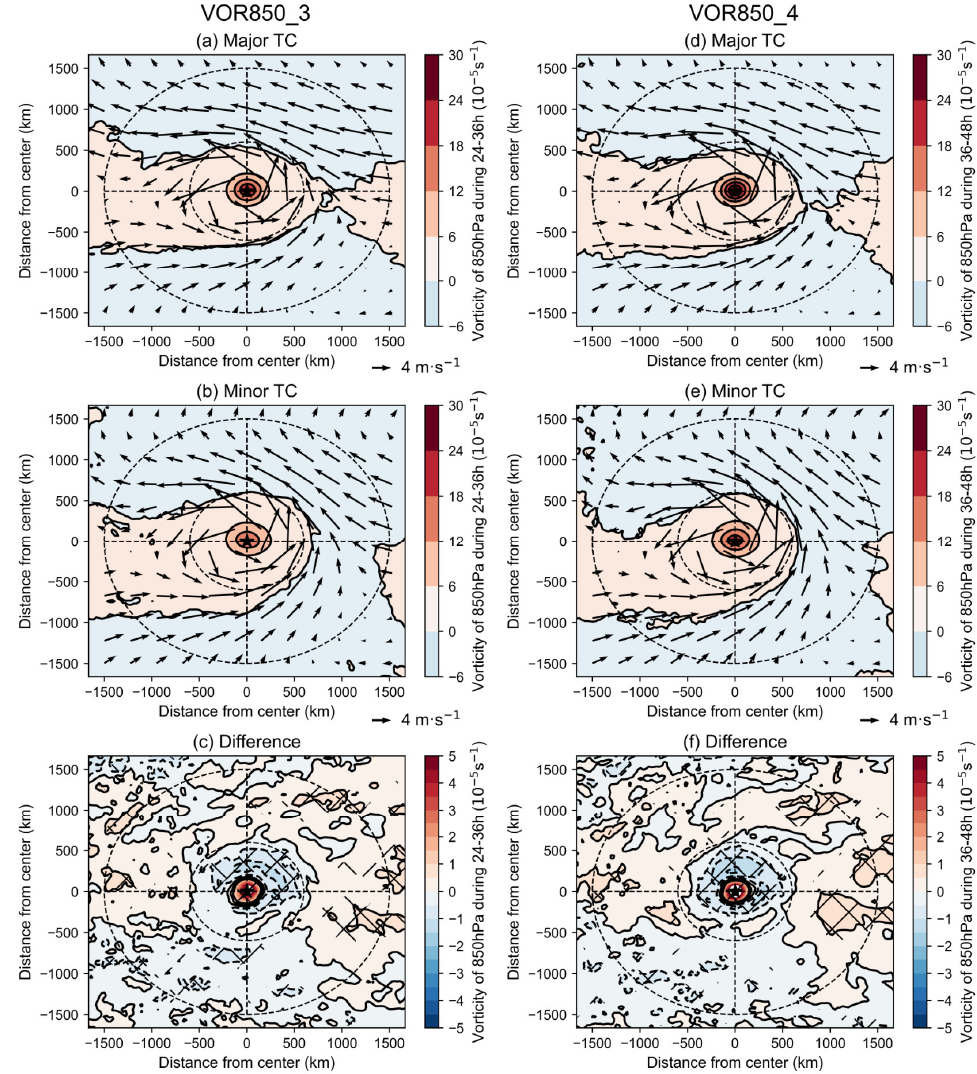
Figure 13. As in Figure 12, but for relative vorticity with wind vectors at 850 hPa (10 −5 s −1 ) during ( a –